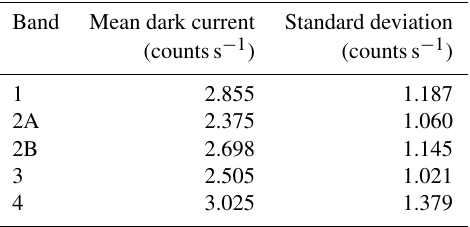
Table 2. Mean dark current measured for each GHOST spectral band (see Sect. 3.2) with the detector at flight temperature (98K). The standard deviations given represent the spatial variability of dark current within each band.